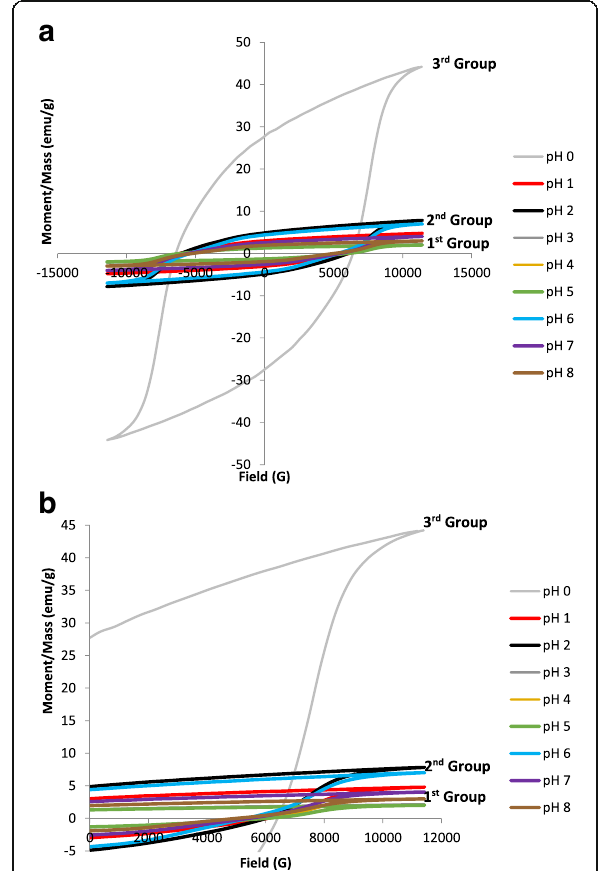
Fig. 8 The M – H hysteresis loops of SrFe 12 O 19 for a pH 0 to pH 8 and b close-up graph, varying pH sintered at 900